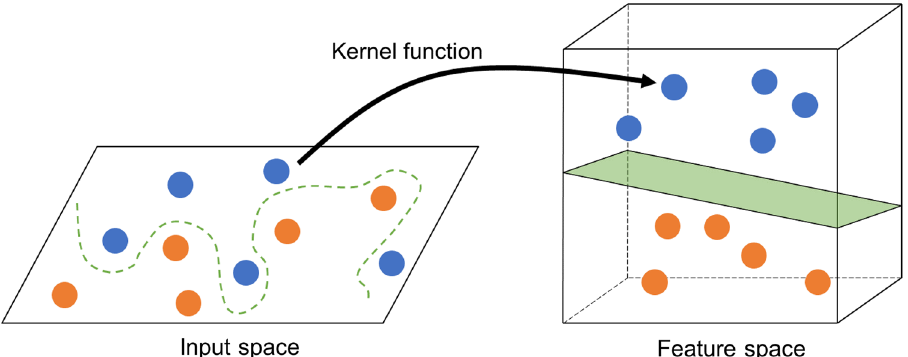
Figure 3. The basis of SVM